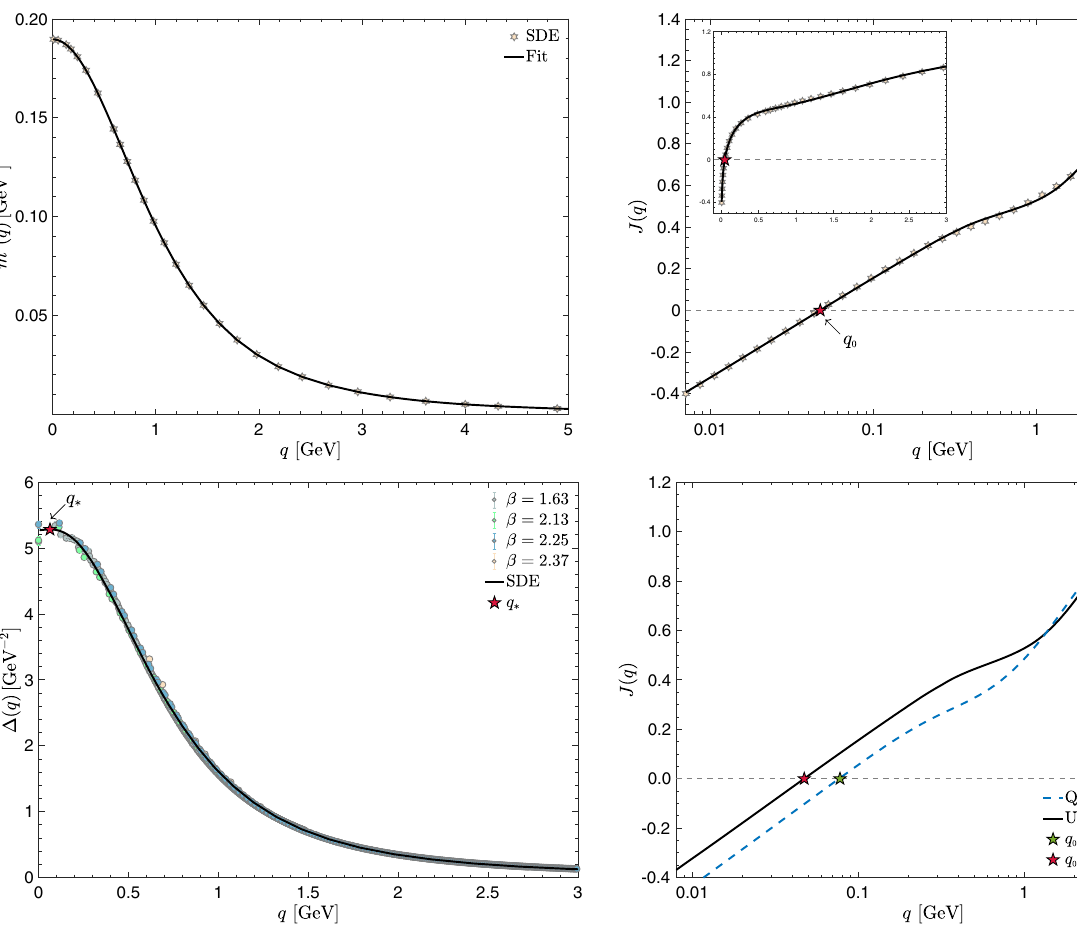
Fig. 2 Top left panel: the dynamical gluon mass, m 2 ( q ) , obtained from Eq. (3.7) and fitted by Eq. (3.8). Top right panel: the J ( q ) obtained through the procedure described in points ( P 1 )-( P 5 ), and the corresponding fit, given in Eq. (3.9). Bottom left panel: Comparison of the unquenched gluon propagator, (cid:5)( q ) , obtained from Eq. (3.1)